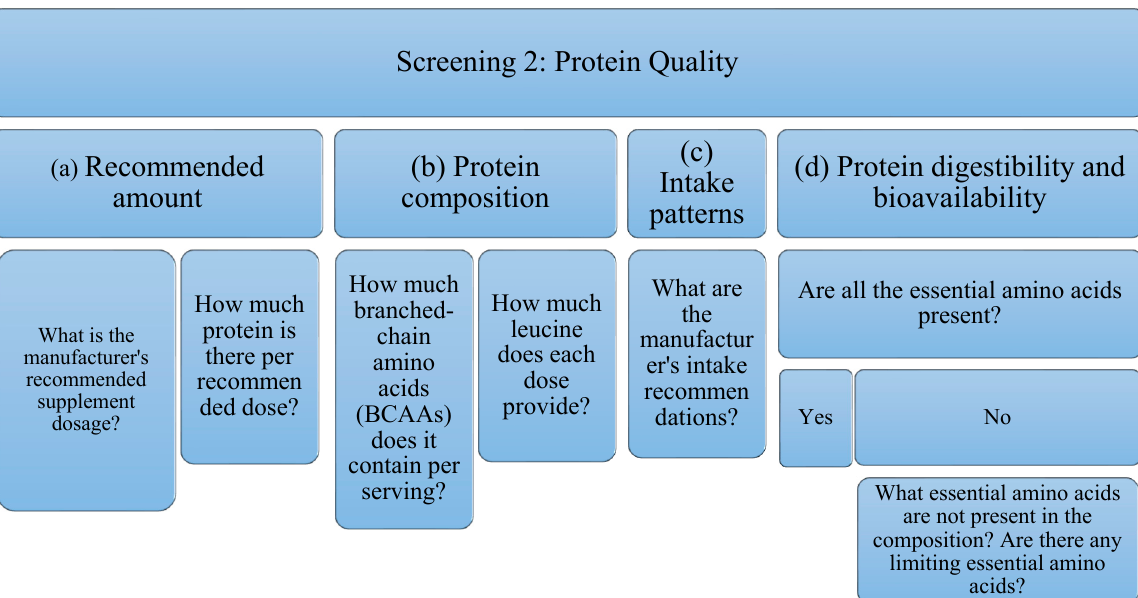
Figure 2. Flowchart Screening 2. It evaluates the manufacturer’s recommended dose, the amount of protein per recommended dose, as well as the amount of BCAAs (leucine, isoleucine, valine) and leucine. In addition, intake patterns, digestibility, and bioavailability are examined.